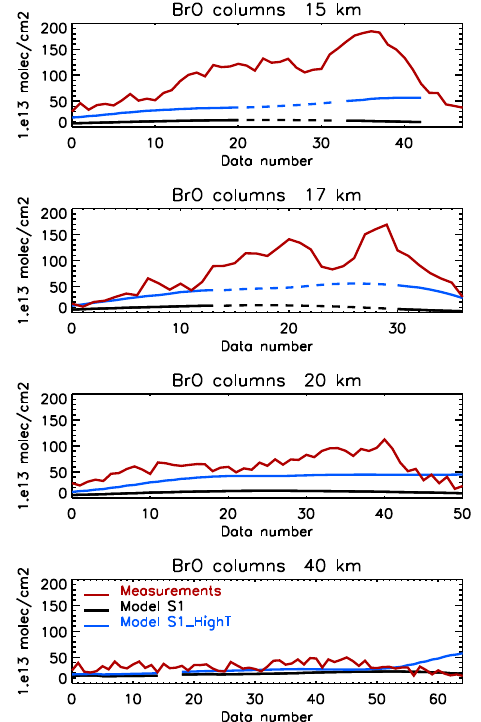
Figure 3. Comparison between SO 2 columns observed by Bani et al. (2009) (red line) and simulated by the model for S1 (black line) and S1_HighT (blue line). Each panel represents a traverse of the Ambrym plume in the crosswind direction on the 12 January 2005 between 05:00 and 06:00UTC, at a range of distances downwind. The traverse at 21km from the source is not shown here but is in- cluded in Table 5. The x axis shows the data point number in the transect across the plume (Bani et al., 2009). The direction of each transect across the plume has an east–west component. Here, each transect is shown with the data points from west to east (left to right). Note that model results are for the same position and time as the measurements and for the finest grid (0.5km × 0.5km) ex- cept when GPS data (longitude and latitude) were not available. In this case, model results (dashed lines) were interpolated between the last and the next positions for which we had GPS data. Note that black and blue lines are on top of each other (superimposed). Re- ported error from DOAS measurements (1 σ) is 2.45 × 10 16 molec cm − 2 .